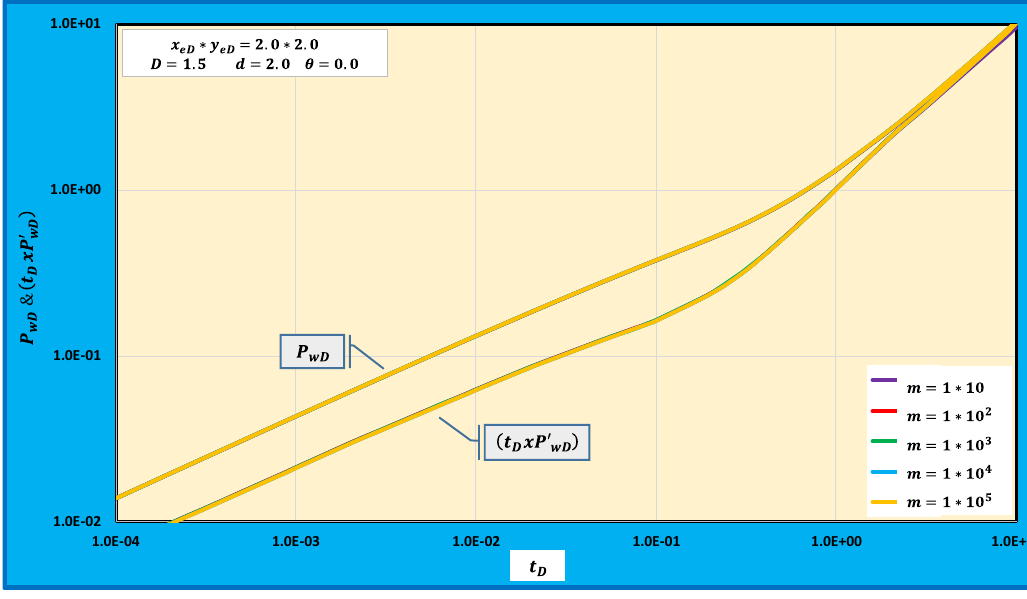
Fig. 8 Wellbore pressure and pressure derivative of different fractal-network